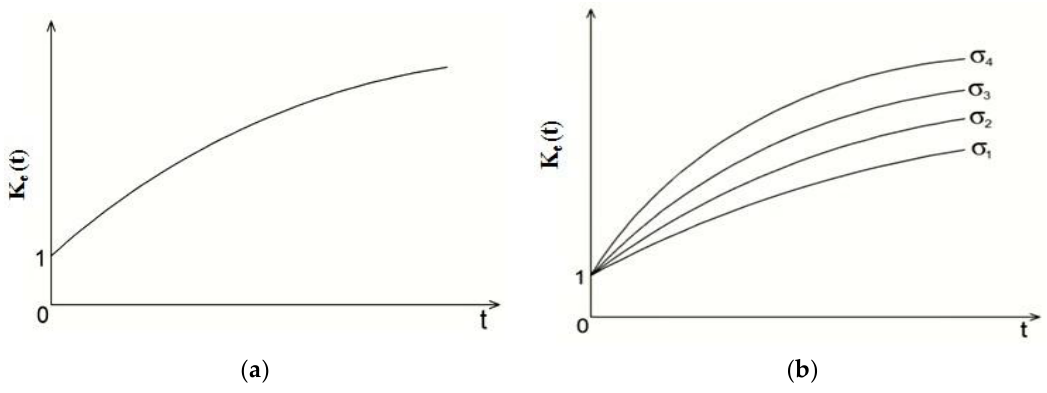
Figure 3. Curves of experimental rheological parameter K e ( t ) at various stresses σ: ( a ) for physically linear material; ( b ) for physically nonlinear material.